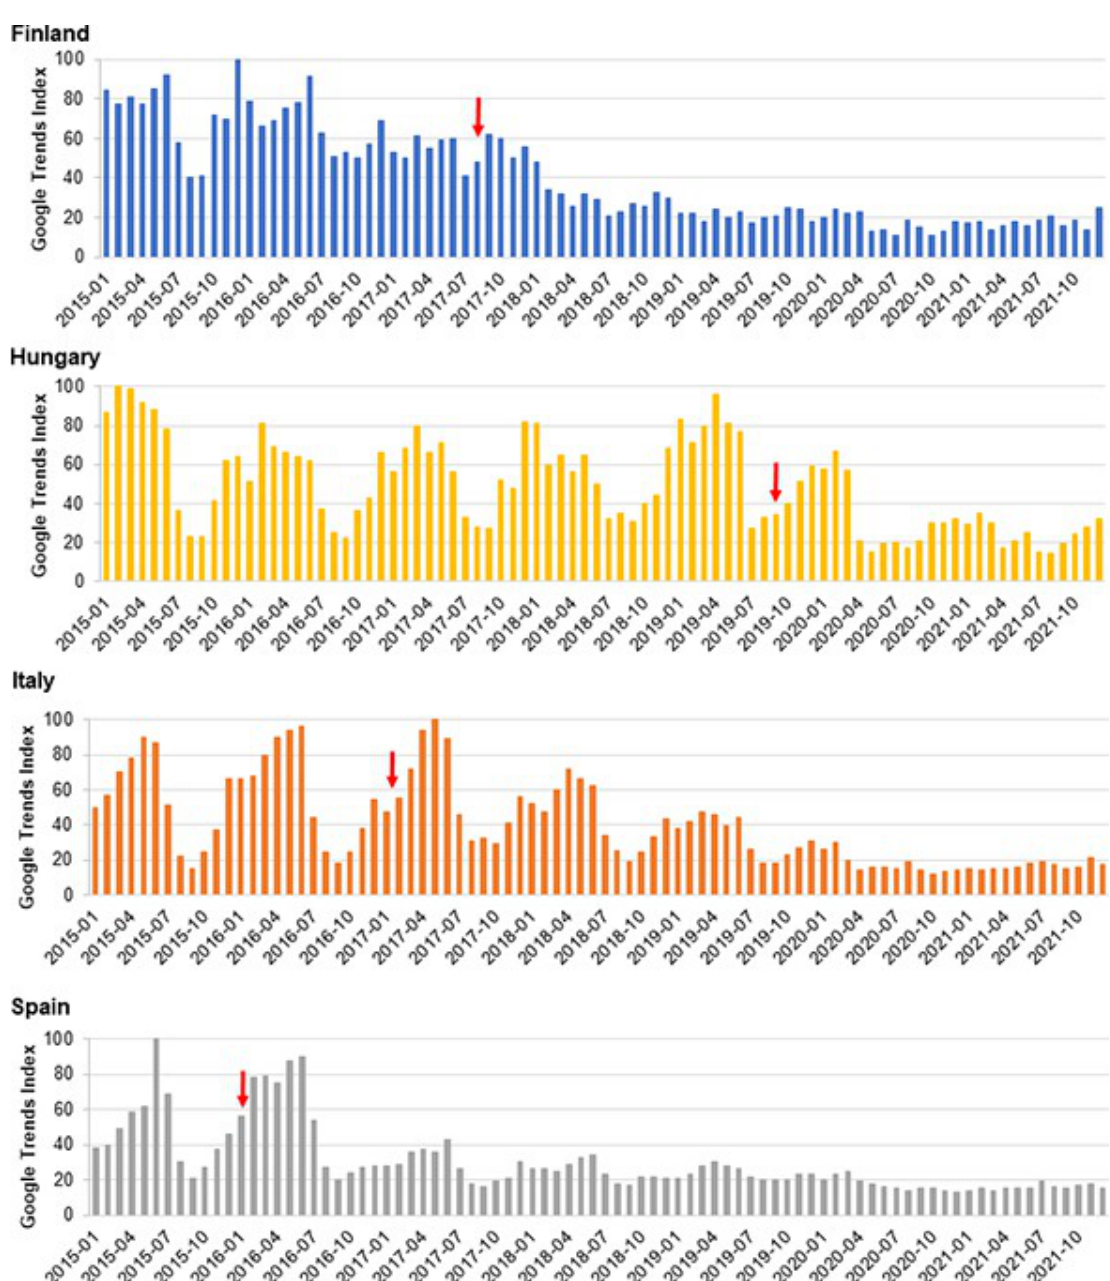
Fig 2. Monthly relative search query popularity of varicella keywords, 2015 to 2021, in four countries with UVV: Finland, Hungary, Italy, and Spain. The Google Trends Index reflects the relative search query popularity. The red arrow indicates when UVV was introduced into the